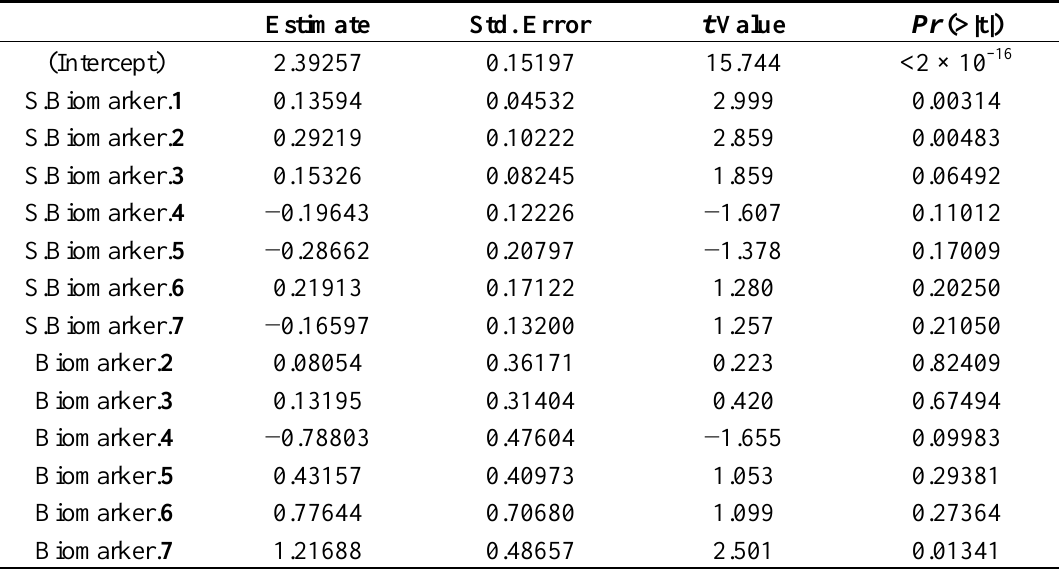
Table 4. The S -values of the biomarkers in the meta-analysis.